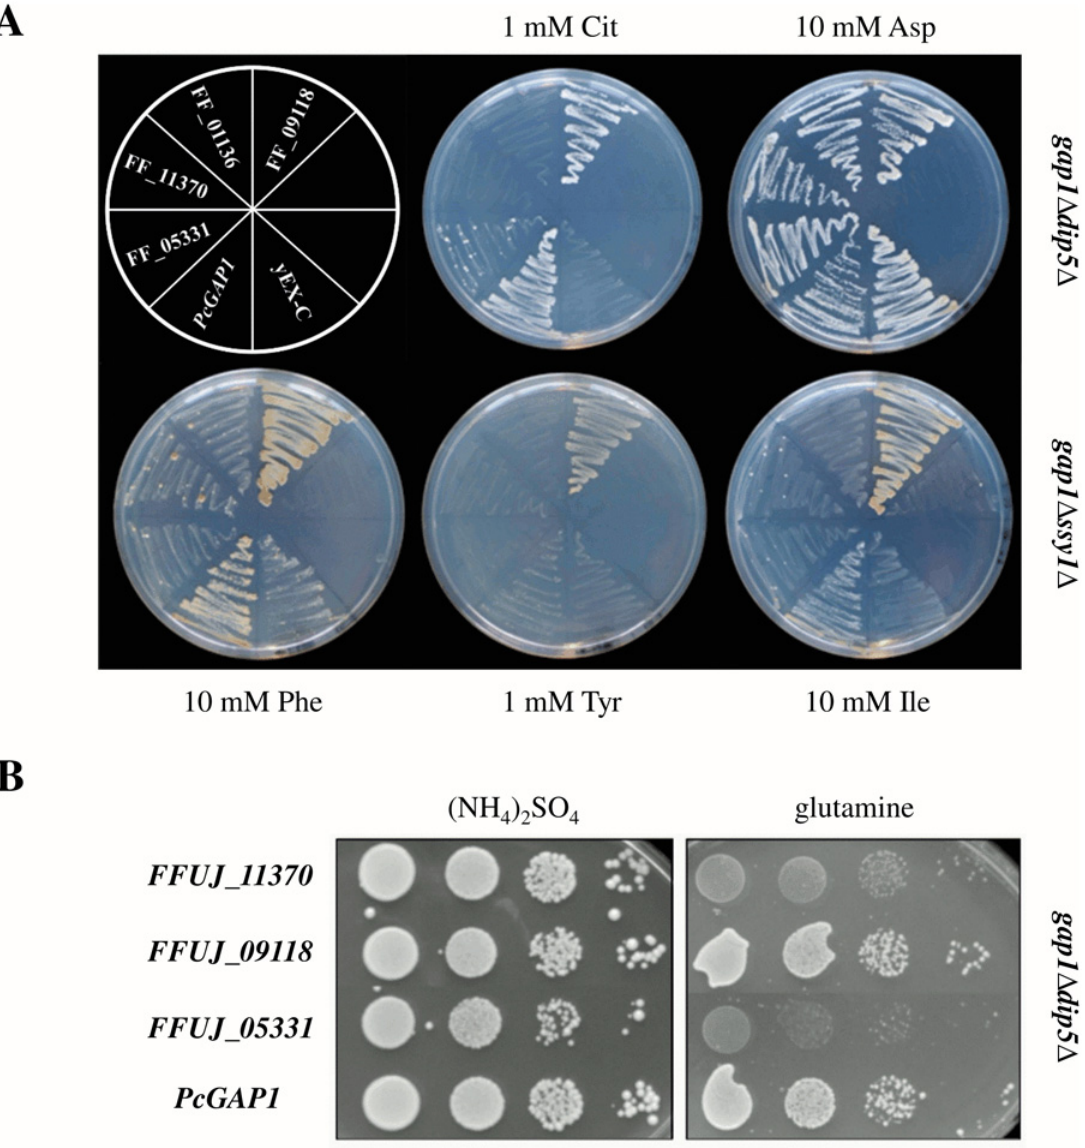
Fig 2. FFUJ_09118 is a functional homologue of S . cerevisiae Gap1. Nitrogen utilization growth assay of S . cerevisiae mutants gap1 Δ dip5 Δ and gap1 Δ ssy1 Δ complemented with putative GAP-encoding genes of F . fujikuroi ( FFUJ_01137 , FFUJ_05331 , FFUJ_09118 , FFUJ_11370 ) and PcGAP1 of P . chrysogenum . Fresh cells of tested yeast strains were adjusted to an optical density of 1 and (A) plated on yeast minimal agar with 1 mM citrullin (Cit), 10 mM aspartate (Asp), 10 mM phenylalanine (Phe), 1 mM tyrosin (Tyr) or 10 mM isoleucine (Ile) or (B) a series of 10-fold dilutions (left to right) were dropped on yeast minimal agar with 1 mM ammonium sulfate ((NH 4 )SO 4 ) or glutamate as sole nitrogen source. Plates were incubated for 4 days at